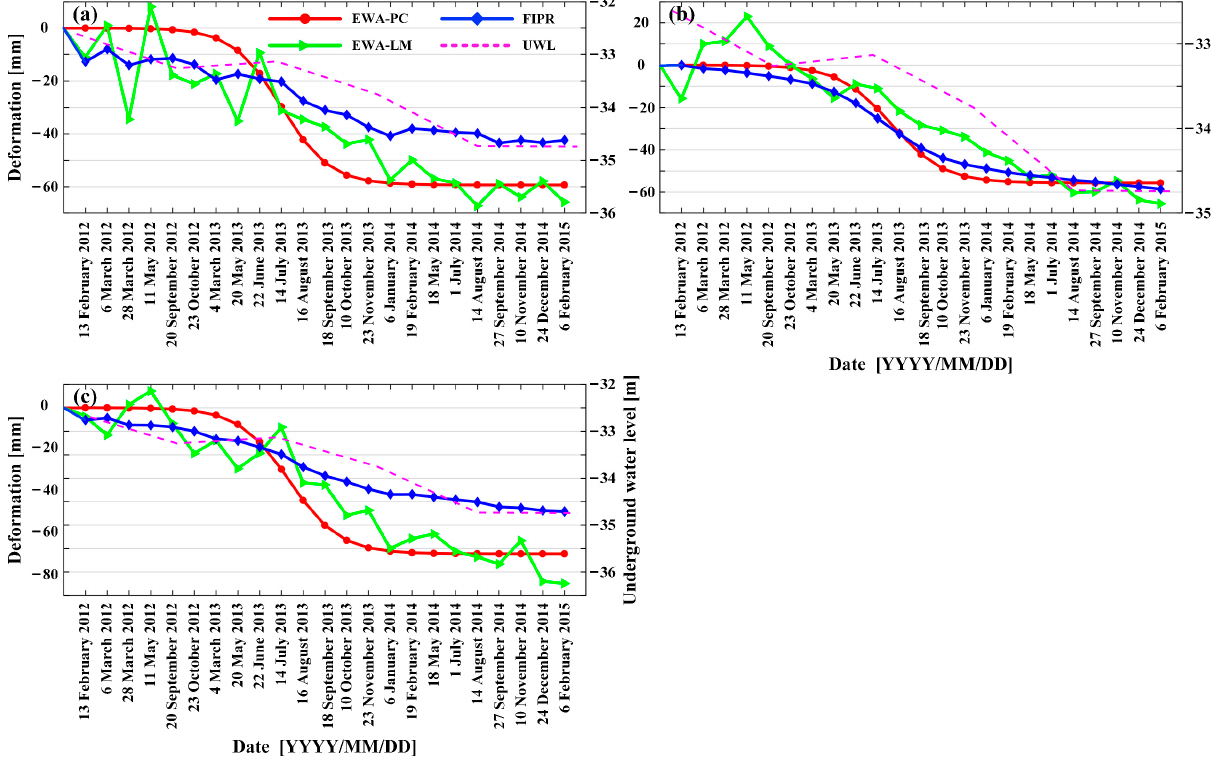
Figure 10. Correlation analysis between the time-series deformation results and the elevations of groundwater level (EWA-LM: linear model with equal weight accumulation; EWA-PC: Poisson curve with equal weight accumulation; UWL: elevation of groundwater level) ( a ): P4; ( b ): P5; ( c ): P6. Table 1. Correlation coefficients between the deformation obtained by the three methods and the groundwater level.